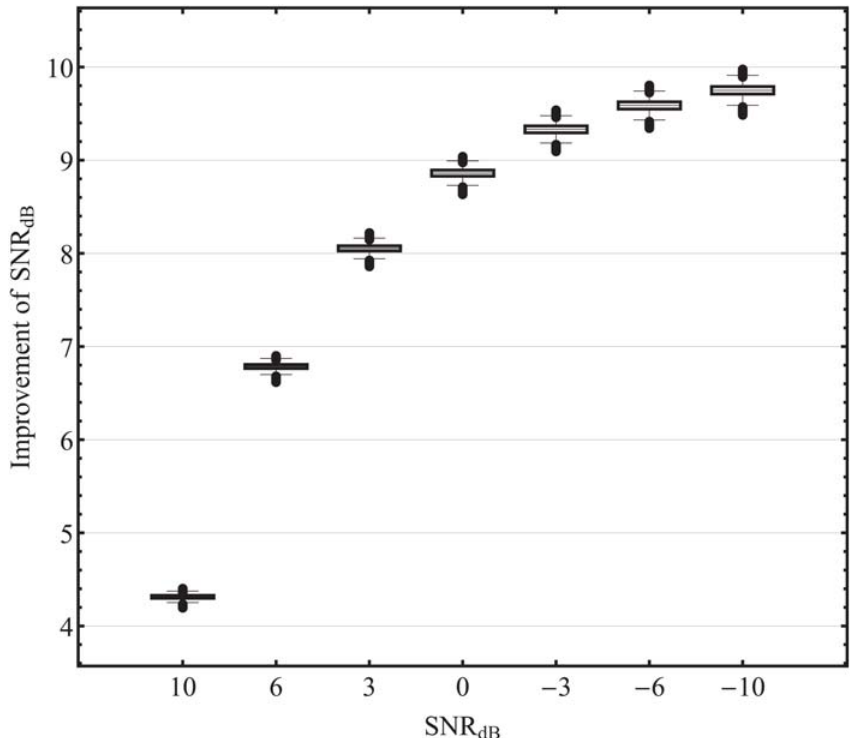
Fig 10. Noise suppression using spatial harmonic low pass filter. Improvement of the SNR (shown on the Y-axis) using a spatial harmonic low-pass filter applied to data with different noise ratios (shown on the X-